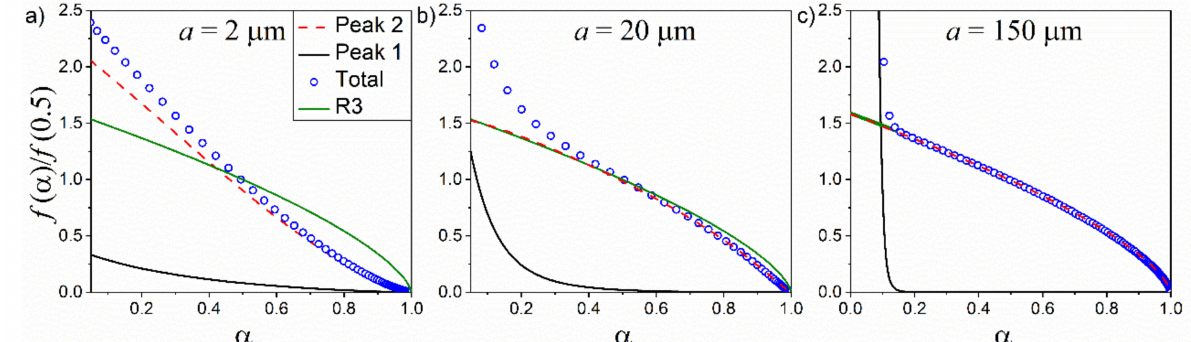
Figure 8. Kinetic models modified by the consideration of the bimodal PSDs. The curves that represent the contribution of the peaks are plotted as lines, while the total kinetic model is depicted as a set of blue open circles. The separation between the two peaks of the bimodal PSDs was set at ( a ) 2 µ m, ( b ) 20 µ m and ( c ) 150 µ